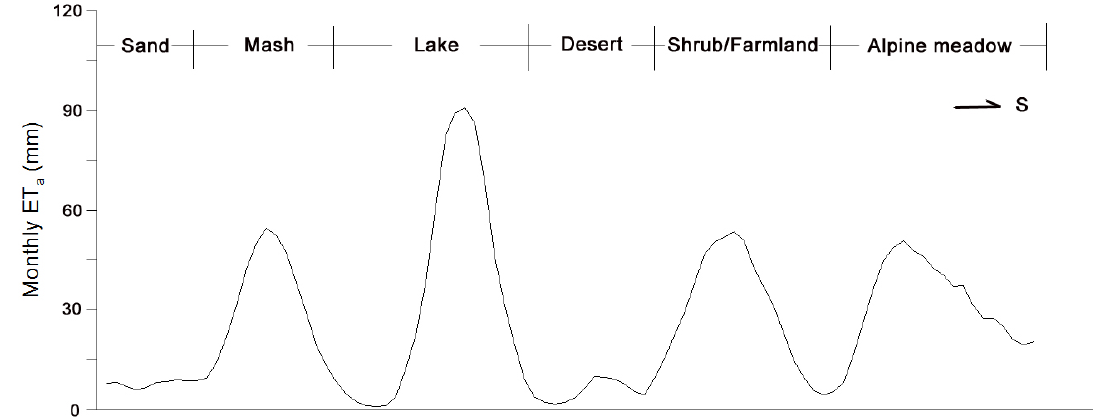
variation for different land cover a